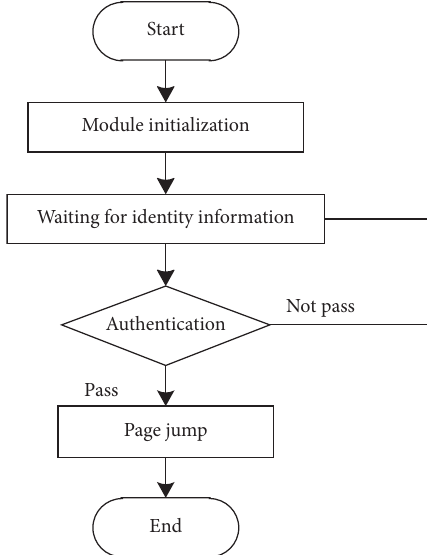
Figure 5: Authentication